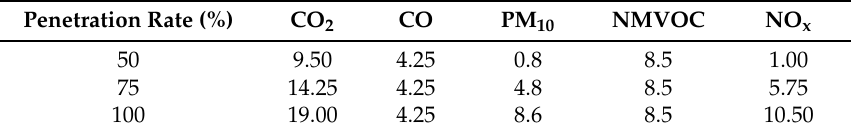
Table 6. Avoided emission for public transport in Province of Trapani [18].